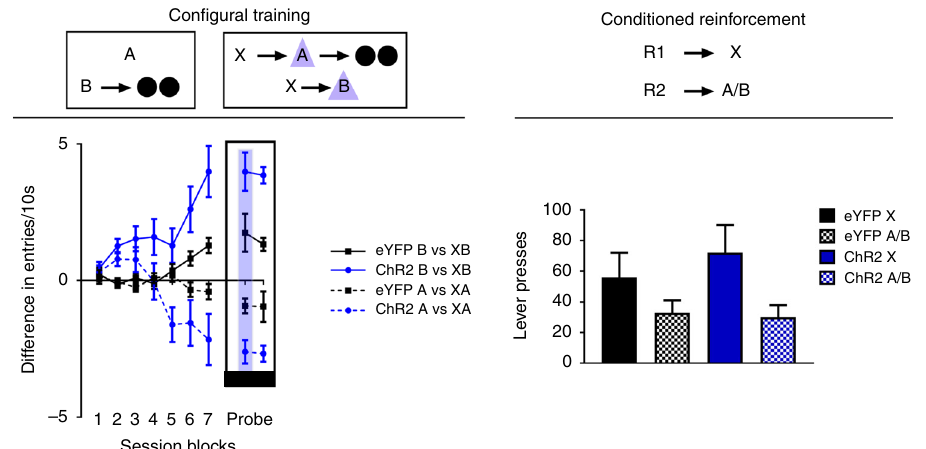
Fig. 4 Brief optogenetic stimulation of dopamine neurons facilitates con fi gural learning without endowing cues with value. Left panel: Stimulation of dopamine neurons in the ChR2 group ( n = 6) facilitates con fi gural learning, relative to our eYFP control group ( n = 6). A and B indicate auditory cues, X indicates a visual cue, and black circles show delivery of food pellets. VTA dopamine neurons were activated by light delivery (blue triangle) at the beginning of A and B only when preceeded by X. In a fi nal session of con fi gural training (Probe Test, outlined with black rectangle), we presented rats with a standard con fi gural training session, with the exception that half the con fi gural trials were presented with light (shadowed column in blue), and the other half were presented without light. For raw data during con fi gural training, see Supplementary Fig. 5. Right panel: Stimulation of dopamine neurons during con fi gural training does not produce changes in conditioned reinforcement. R1 and R2 indicate differently positioned levers, and rates of responding are represented as total number of lever presses within a session (±SEM). For individual rats ’ responses during conditioned reinforcement testing, see Supplementary Fig.